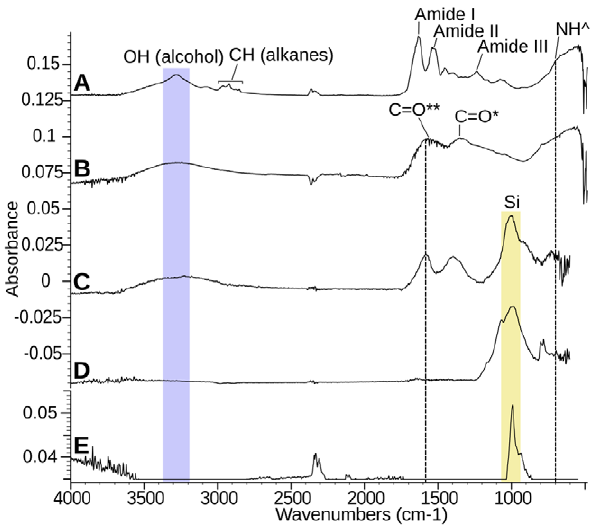
Figure 3. FTIR point analyses of Sepia officinalis eumelanin, Gansusyumenensis and extant feathers. (A) Extant Marabou stork feather, (B) Sepia officinalis eumelanin, (C) the dark area of an isolated Gansus yumenensis feather (MGSF317) and its associated matrix (D). *C=O represents a group from a carboxylic acid, **C=O represents a group from either a carboxylic acid or a ketone, NHˆ represents a group from a secondary amine; inorganic peaks are shown with a yellow band. (E) Shows the resultant spectra when that of the natural S. officinalis melanin is subtracted from that taken from the dark area of the feather. Vertical dashed lines at 1582 cm -1 represent the C=O group of the ketone or asymmetric stretch of the carboxylic acid, and at 700 cm -1 represents the N-H wagging group of the secondary amine, the blue band represents the OH hydroxyl group.